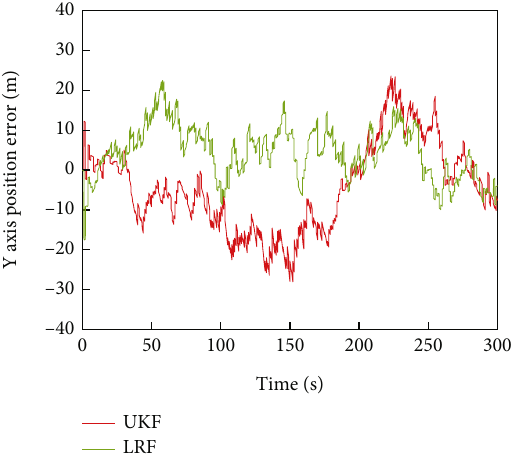
Figure 10: Y -axis position error contrast curves